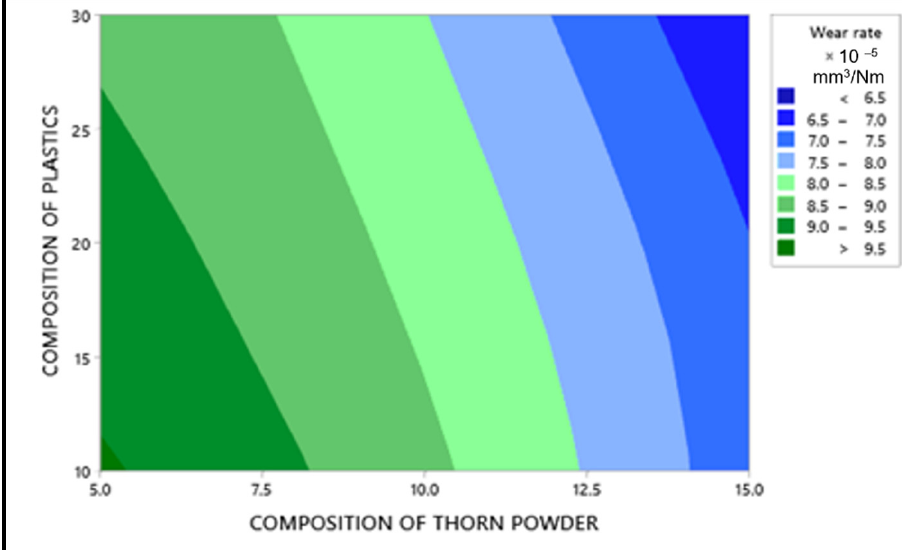
Figure 16. Wear rate results through contour graph. Table 6. Wear rate results from